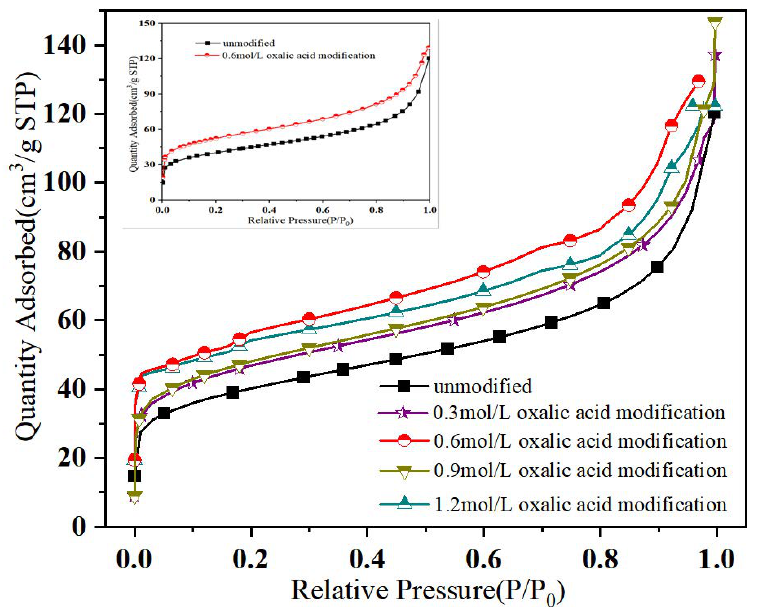
Figure 2. N 2 adsorption curves of activated carbon under different modification conditions.